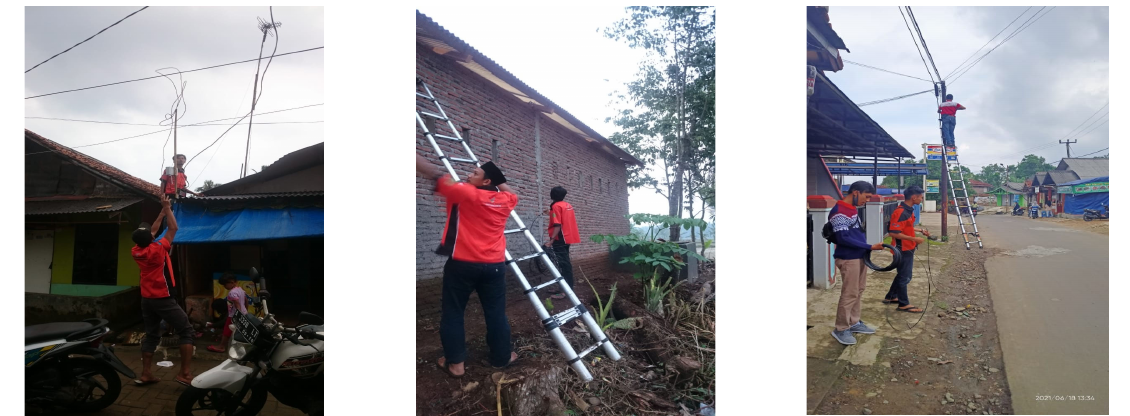
Fig. 7. Internet network installation activities by Kompak in the Kabandungan Sub-district